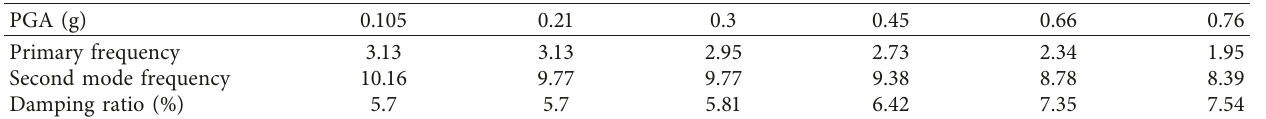
Figure 5: Crack of typical components: (a) coupling beam, (b) frame beam, (c) slab of beam end, and (d) intersection of column and Table 11: Damping and frequency of normative model.